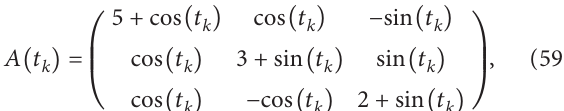
and x . (d) Trajectories of y 21 21